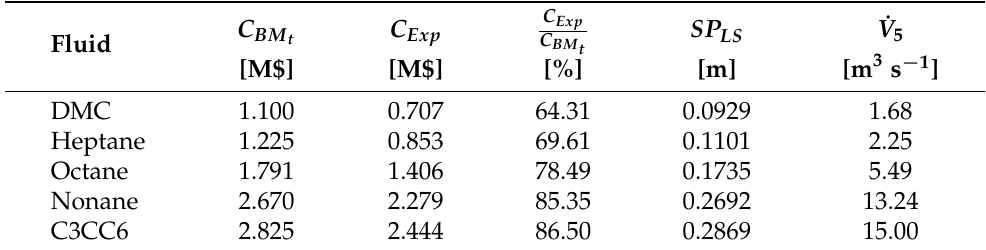
Table A11. Economic analysis results of the ORC fluids in the case of using water as heat transfer medium in the thermal loop.